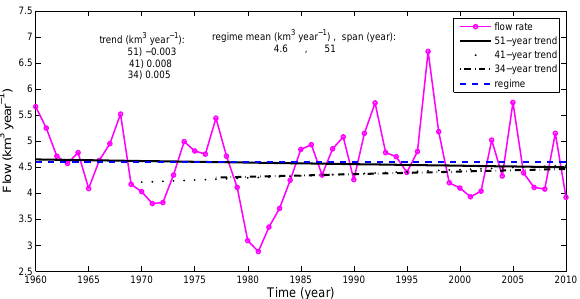
Fig. 8. Input flow rate to Lake Athabasca and the significant detected trends for three different analysis periods. These trends are significant with p values of 0.10, 0.00, and 0.03 for analysis peri- ods of 34, 41, and 51yr,